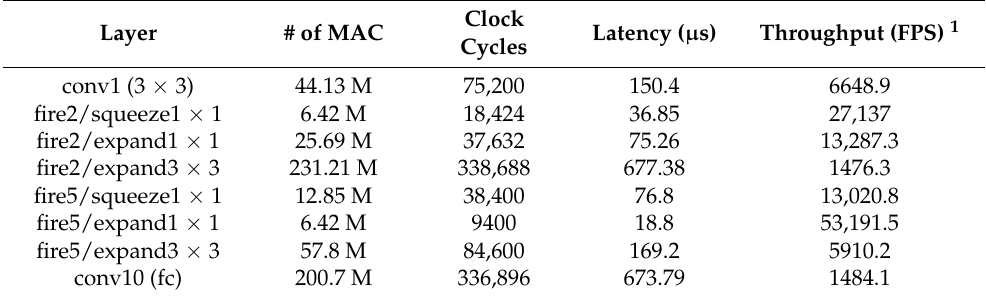
Table 3. Latency and throughput of 32 × 32 Gemmini (1024 GOPS) running at 500 MHz